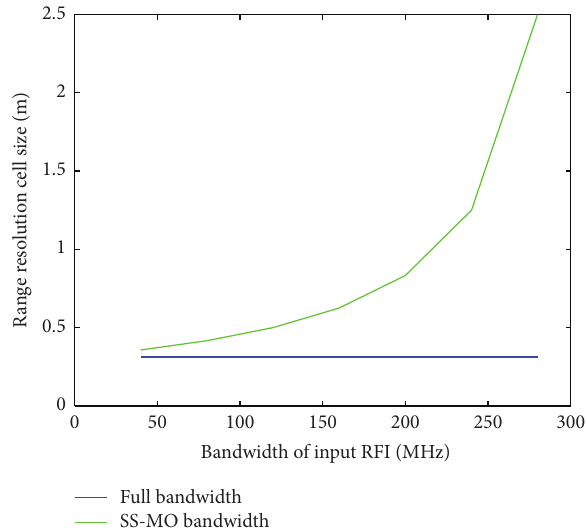
Figure15:TherangeresolutioncellsizeresultsforthewidebandRFI experiment. As is shown, the range resolution cell size is increased when using the SS-MO technique but is within the maximum cell size boundary condition specified by 𝑍2 max = 3.33